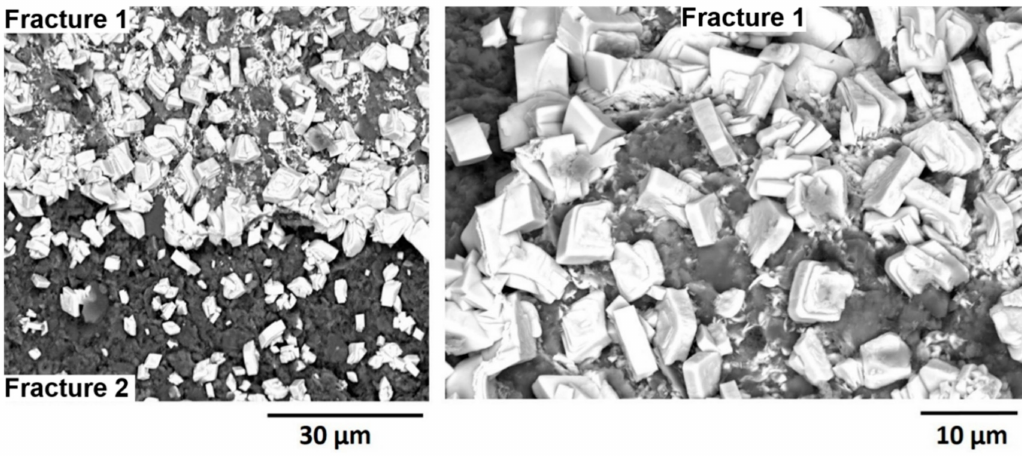
Figure 4. SEM images of barite crystals visible on the surface of two adjacent microfractures. The surface of fracture 1 (top) is superimposed on the surface of fracture 2 (bottom), which most likely